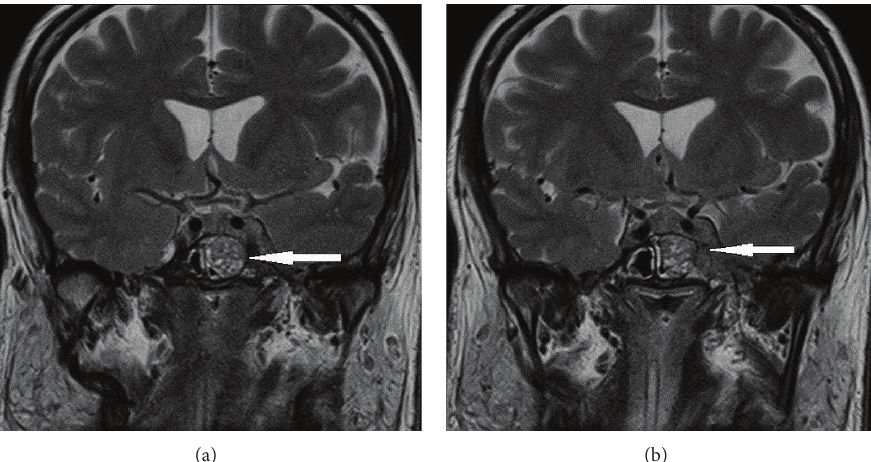
Figure 2: MRI brain (T2-weighted, contrast, and coronal) showing (a) pituitary involvement and (b) invasion into left cavernous sinus (indicated by